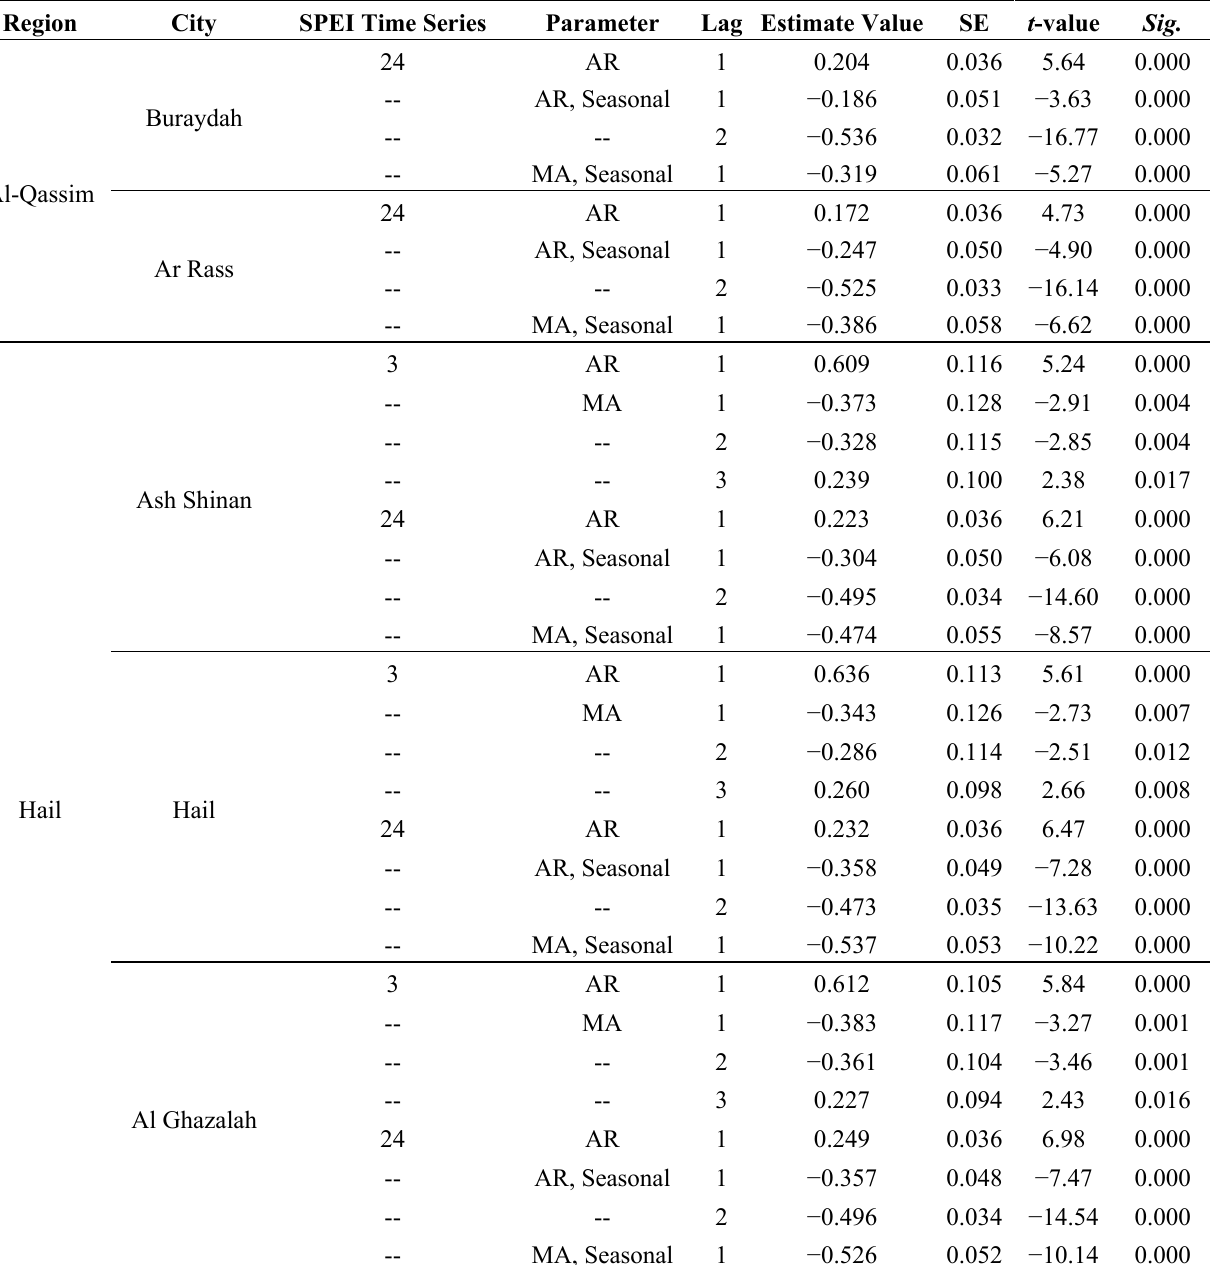
Table 5. Similar parameter estimate values at the same Standardized Precipitation Evapotranspiration Index (SPEI) time scale including the autoregressive (AR) and moving average (MA) orders with associated significance values at significance level < 0.05 for both